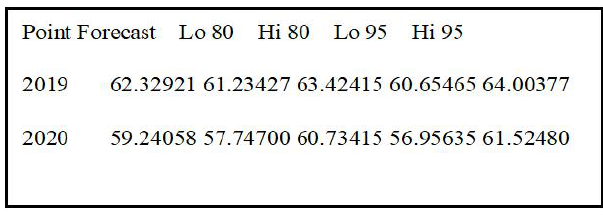
Figure 9. Output data for predicted rank